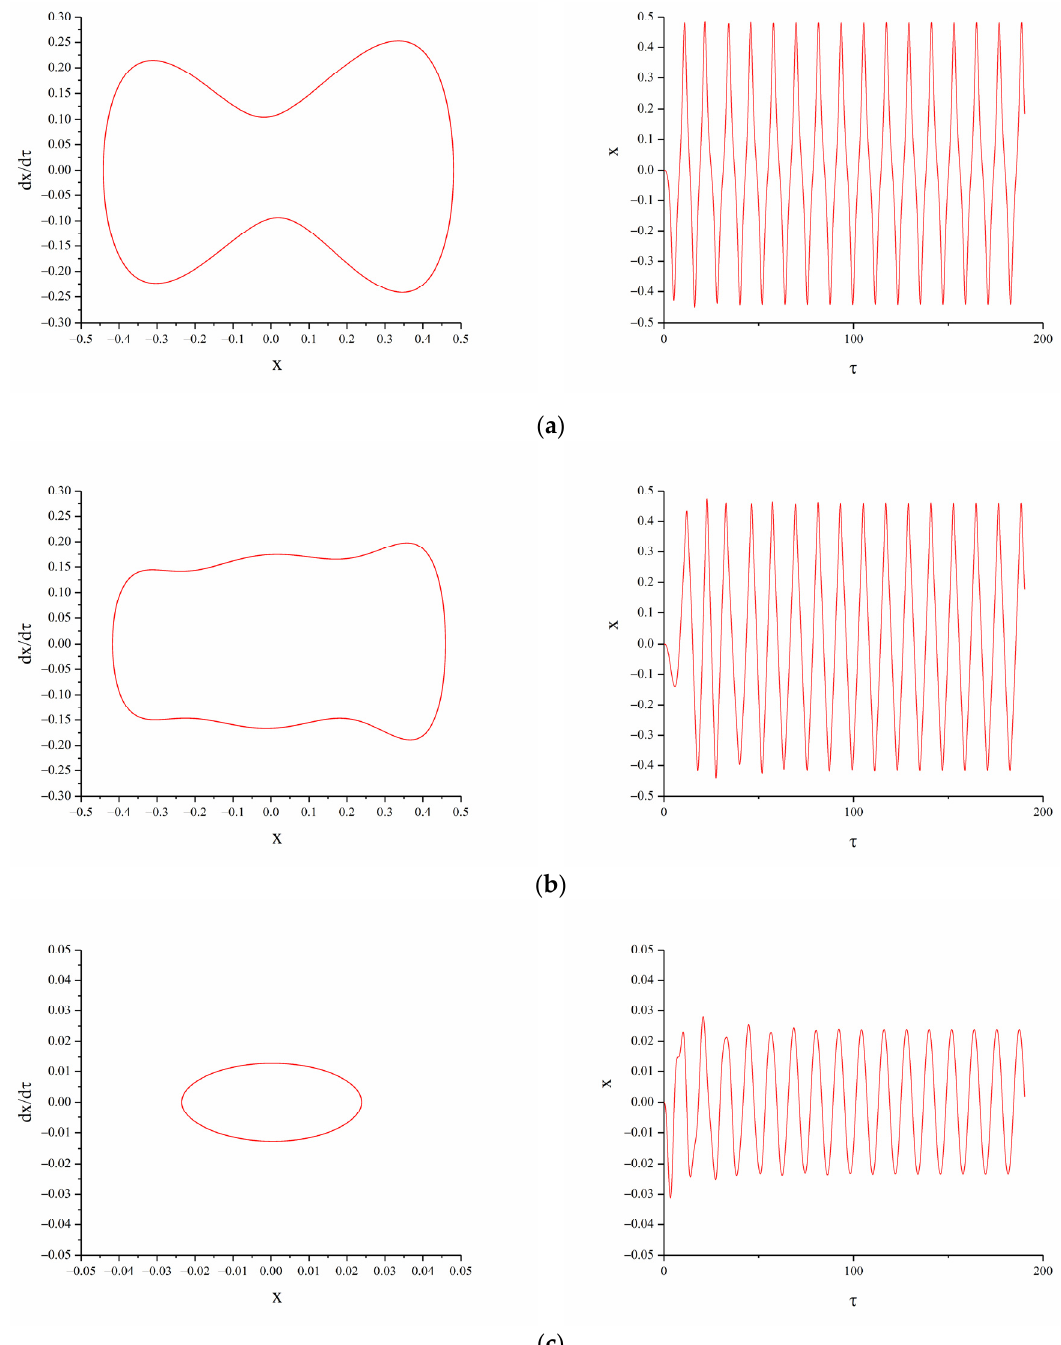
Figure 7. Phase portrait and time-displacement diagram of different magnetic distance 𝑑 (cid:3034) : ( a ) 𝑑 (cid:3034) = 6 mm ; ( b ) 𝑑 (cid:3034) = 8 mm ; ( c ) 𝑑 (cid:3034) = 12 mm .